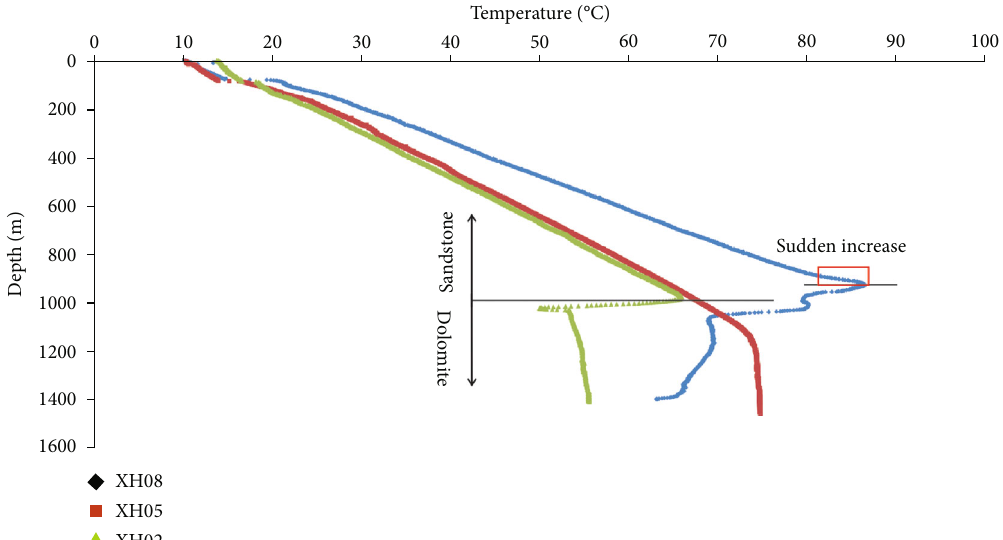
Figure 7: Temperature pro fi les of XH02, XH05, and XH08 wells at Xiongxian geothermal site. The arrows illustrate the extent of di ff erent rock types; the solid rectangle shows the sudden temperature rise in